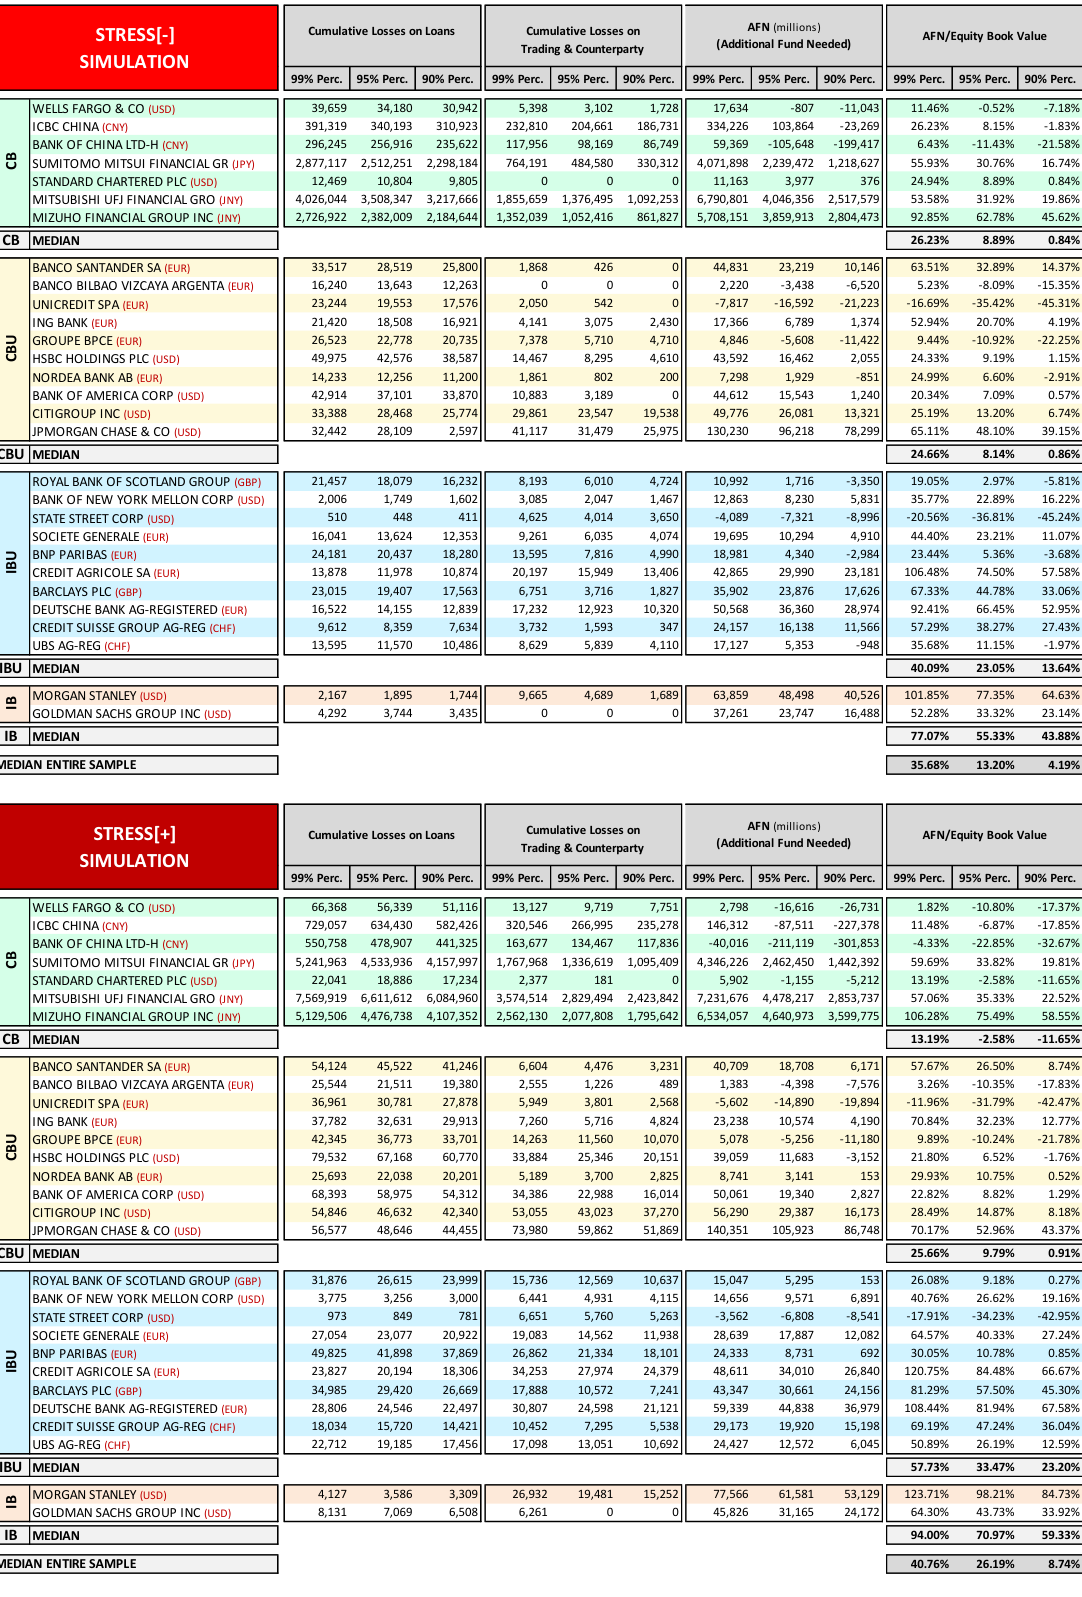
Figure A10. 2016 Stress test exercise: credit/market cumulative losses and funding shortfall.